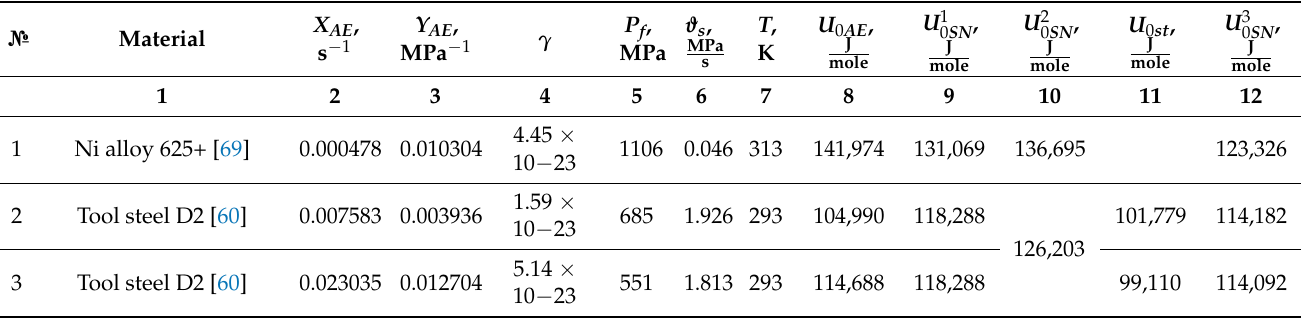
Table 2. Results of calculation of concentration-kinetic AE strength indicators, kinetic parameters, and activation energy of